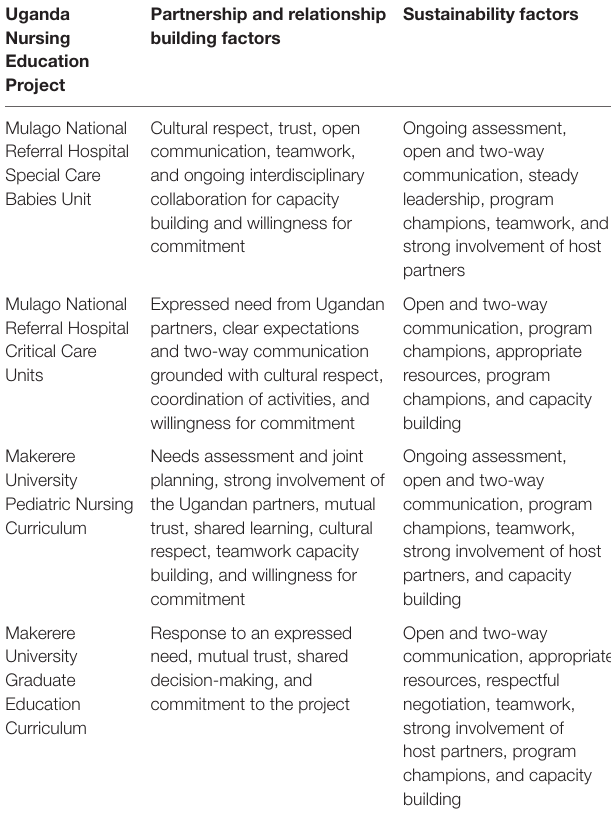
taBle 1 | Case exemplar partnership and sustainability